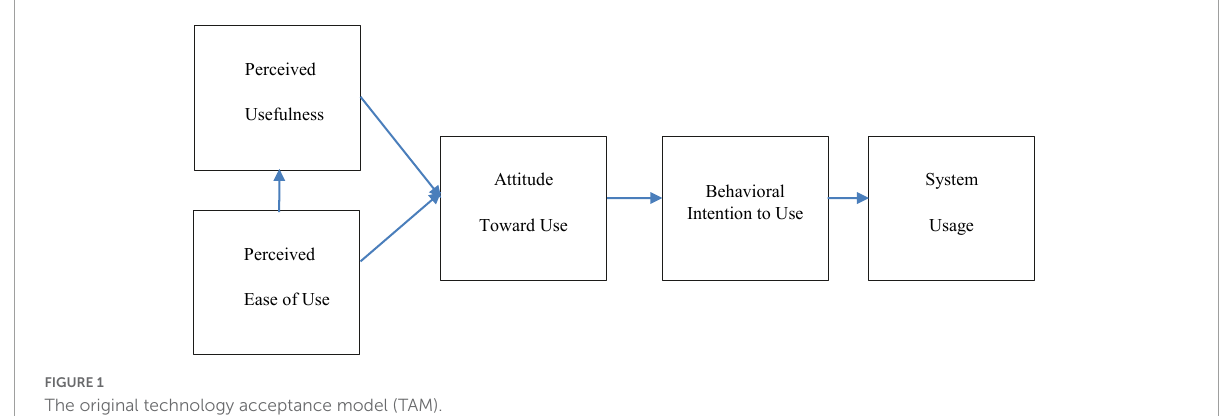
FIGURE1 The original technology acceptance model (TAM).